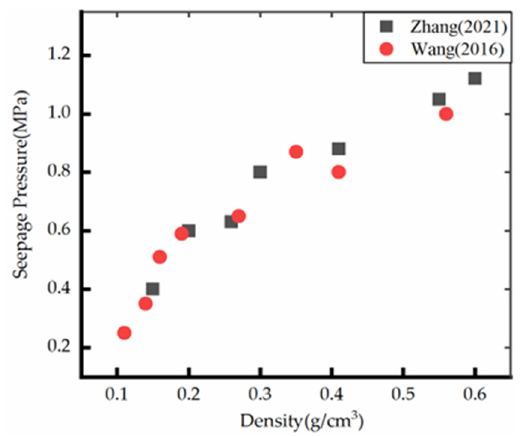
Figure 6. Polyurethane seepage pressure versus density